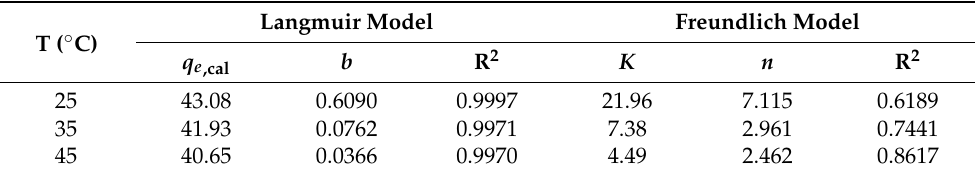
Table 3. Equilibrium parameters for adsorption of Zn 2+ .